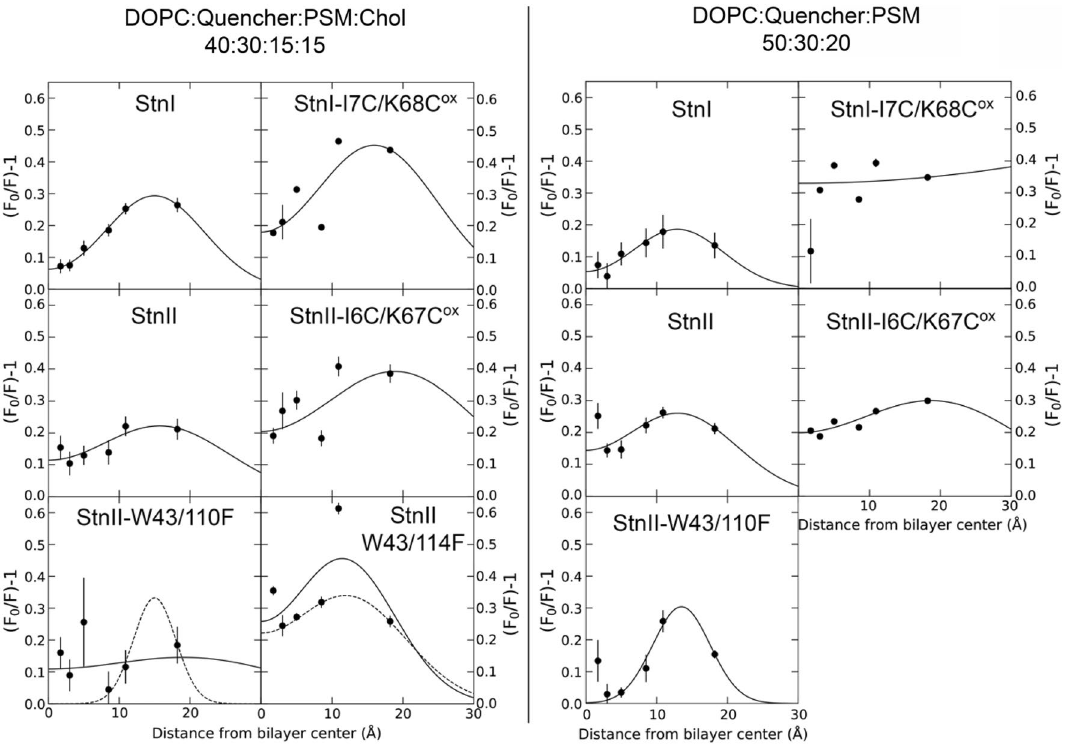
Figure 4. Depth-dependent quenching profiles of Stns in membranes. The obtained profiles represent the most probable depths at which the membrane embedded Trp residues of the indicated toxin variant are found in membranes composed of DOPC:Quencher:PSM:Chol (left side panels) or DOPC:Quencher:PSM (right side panels) in molar relations of 40:30:15:15, or 50:30:20, respectively Solid lines are best fits to Eq. 6. Dashed lines are fits of an alternative analysis in which some of the data has been discarded. This was done on grounds of (1) data deviations from the trend and/or (2) consistency with results obtained for other variants or for the same variant in the other membrane system. Quenching values are average ± SEM of n = 2–3.